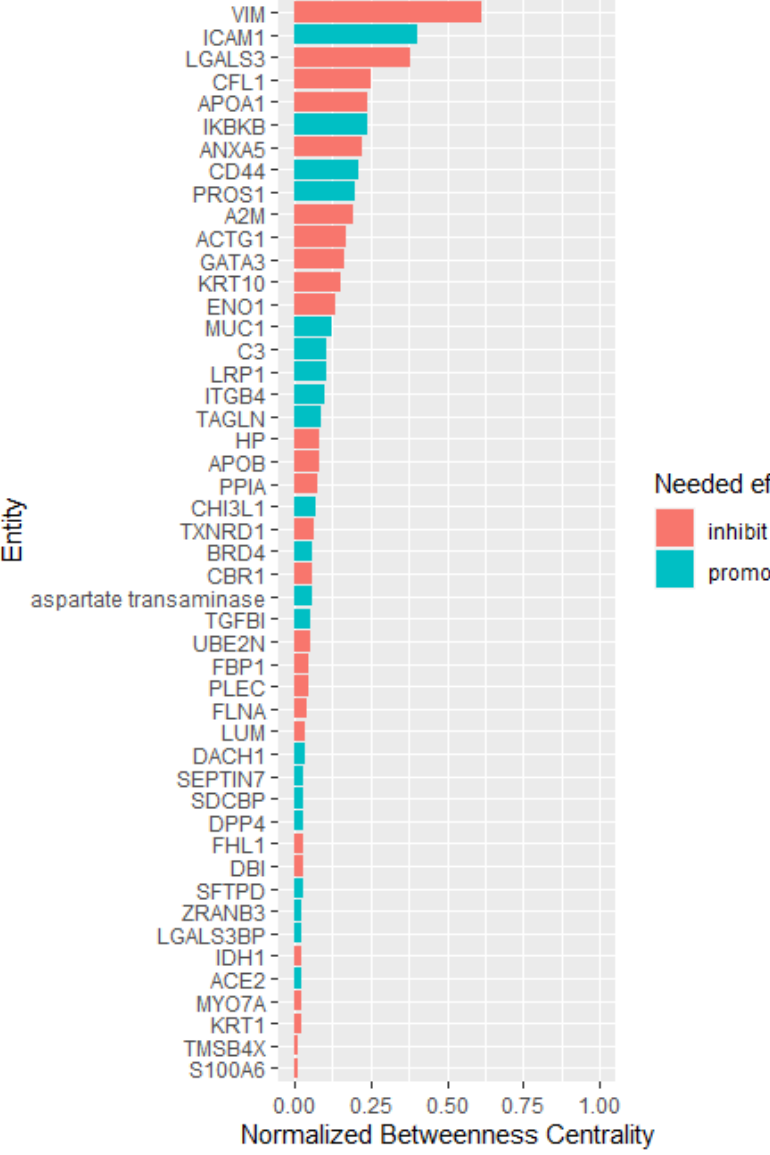
Figure 2. BALF network centrality nodes ranked by betweenness centrality. Betweenness centrality quantitatively describes how a node (in this case, a differentially expressed protein in the BALF proteome) mediates the interaction between communities of neighboring nodes in the network. Shown are 44 network entities with betweenness centrality > 0.01, normalized to the maximum betweenness centrality present in the network. The betweenness centrality scores for all nodes were expressed as fractions of the maximum betweenness centrality present in the network. The (red and blue) colors indicate the needed effect (inhibition/induction) to restore these entities from COPD levels to the normal levels in healthy control subjects. The four nodes with ≥25% of the maximum betweenness centrality (fibronectin) with normalized betweenness centrality values representing a greater than the linear baseline increase from the next lower ranking node are fibronectin, vimentin, intercellular adhesion molecule1 (ICAM1), and galectin-3 (LGALS3). These potential key signaling mediators had a betweenness centrality of at least 25% of the maximum. Topological analysis of the interaction network regulatory interactions documented in the literature suggests that these proteins were central mediators of COPD [38–43]. Colors indicate the needed effect to restore these entities to the normal levels in healthy control subjects.